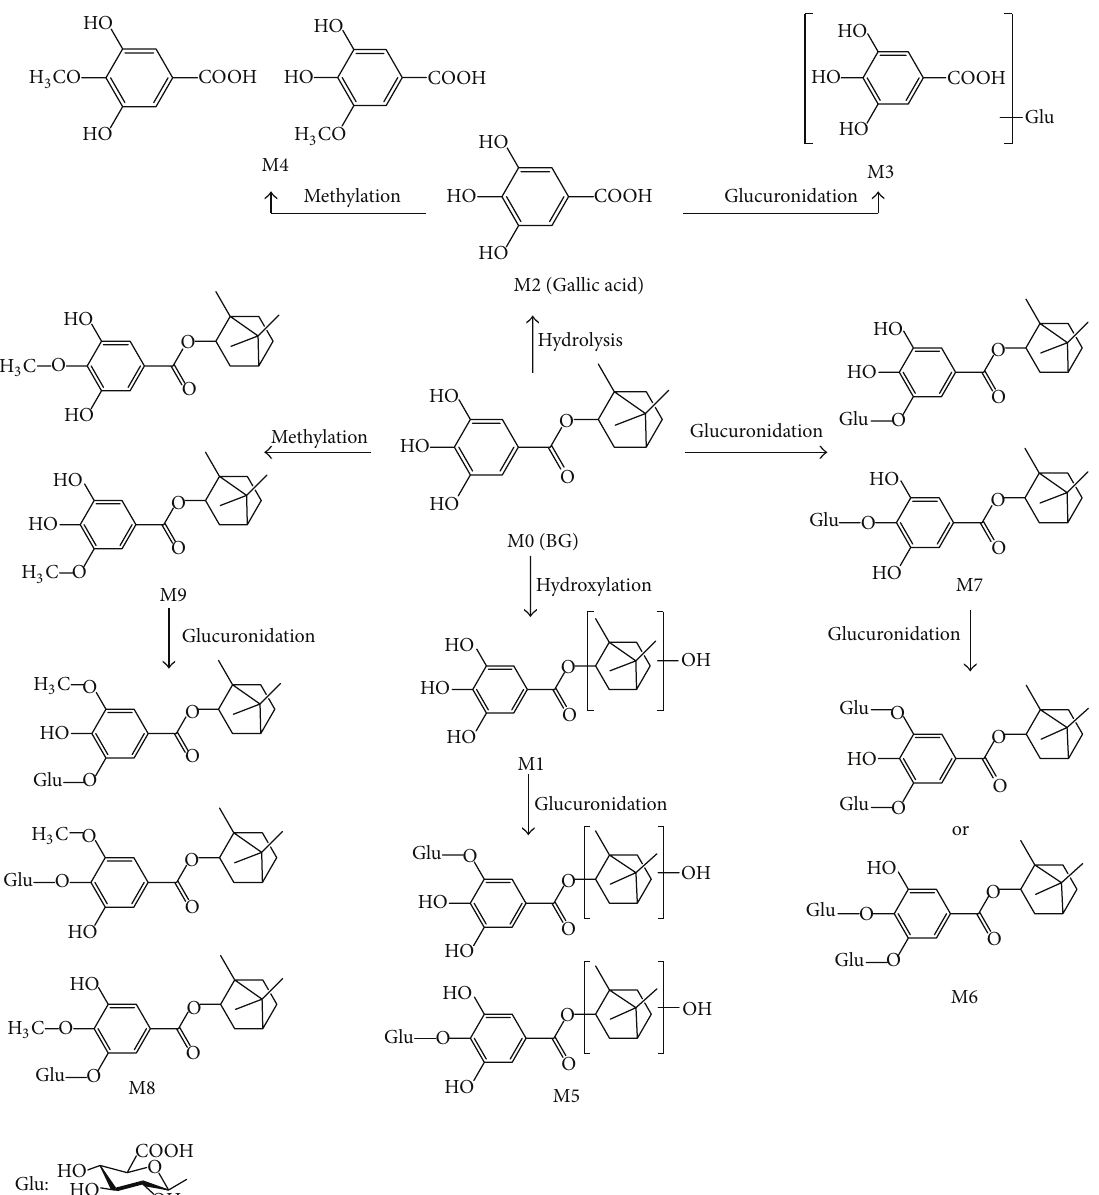
Figure 7: Proposed metabolic pathways of BG in